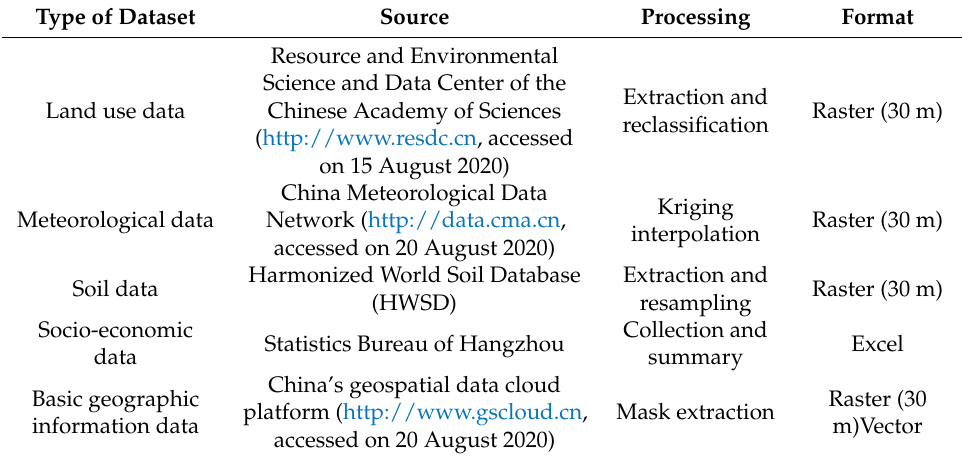
Table A1. Description of the data used in this